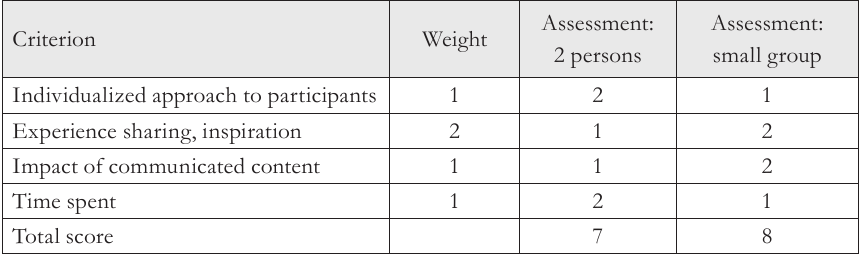
Tab. 3 – Criteria for Assessment of F2F Communication Types. Source: own research